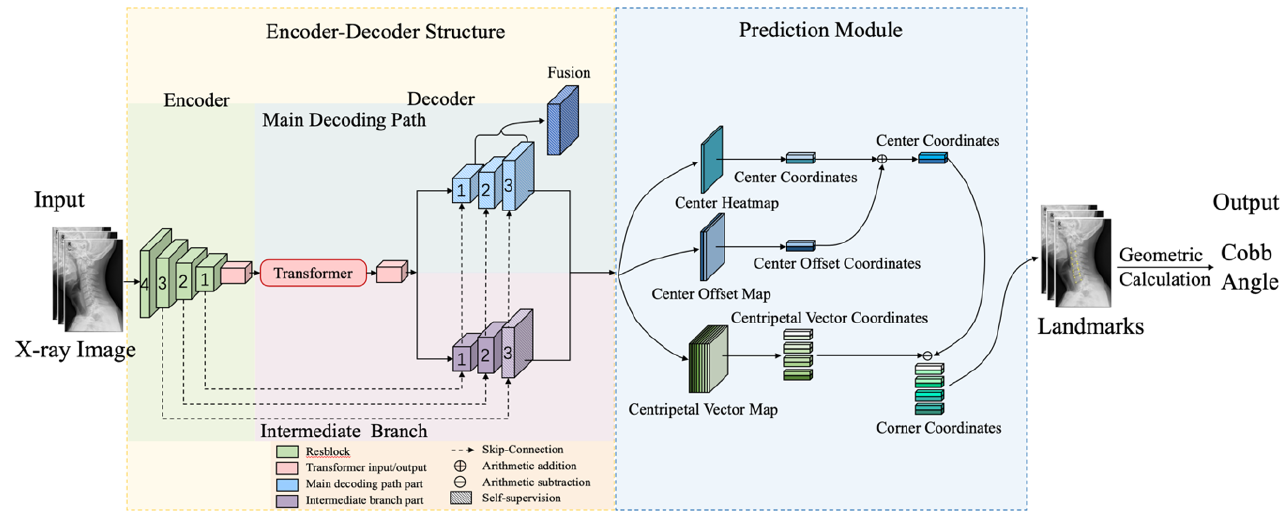
Figure 2. The overall framework of our proposed method. Our model is mainly composed of an encoder–decoder structure and a prediction module. The dimensions of residual modules with the same ID are the same. A transformer is integrated into the middle of the encoder and decoder.